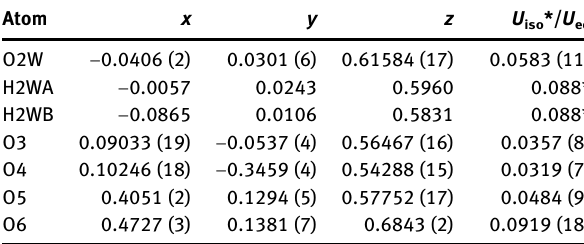
Table  : Fractional atomic coordinates and isotropic or equivalent isotropic displacement parameters (Å 